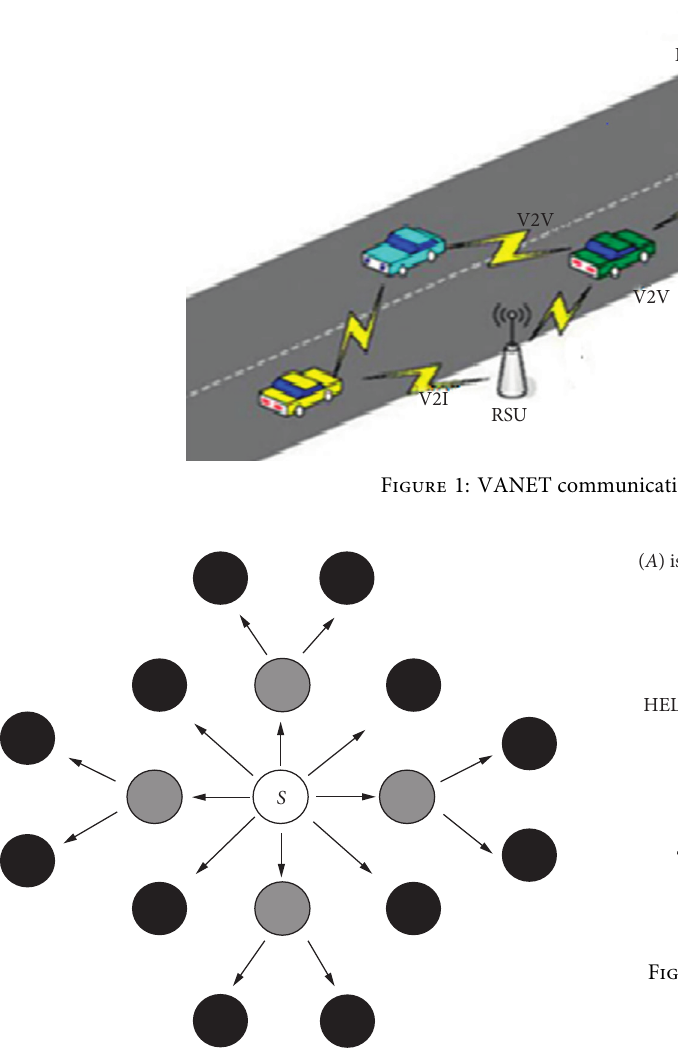
Figure 2: MPR selection and the working principle of the OLSR [8, 9, 12–14].